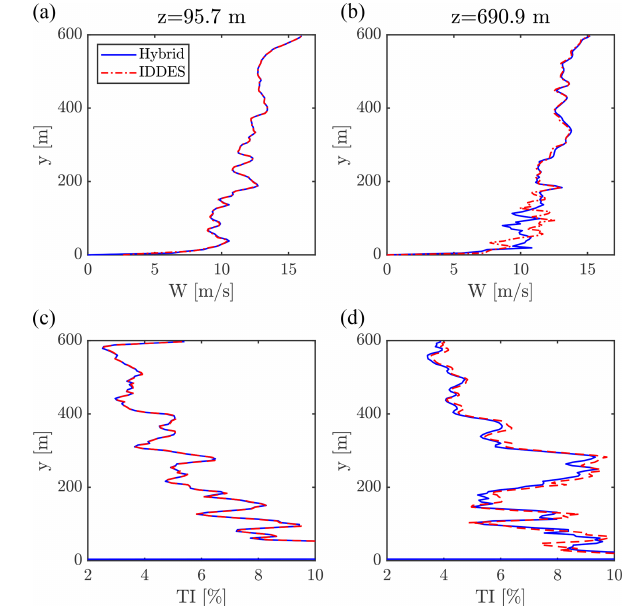
Figure 12. Instantaneous sampled profiles at time = 129.6s. (a, b) Flow velocity W , (c, d) turbulence intensity (TI). Samples extracted from planes close to the inlet (96m from inlet) and far downstream (691m from inlet); see dashed lines of Fig.